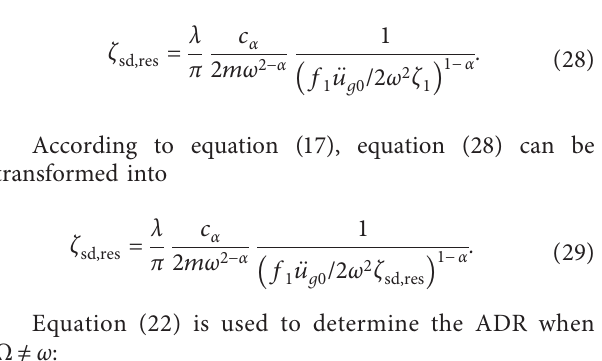
Figure 7: Fitting curve of a